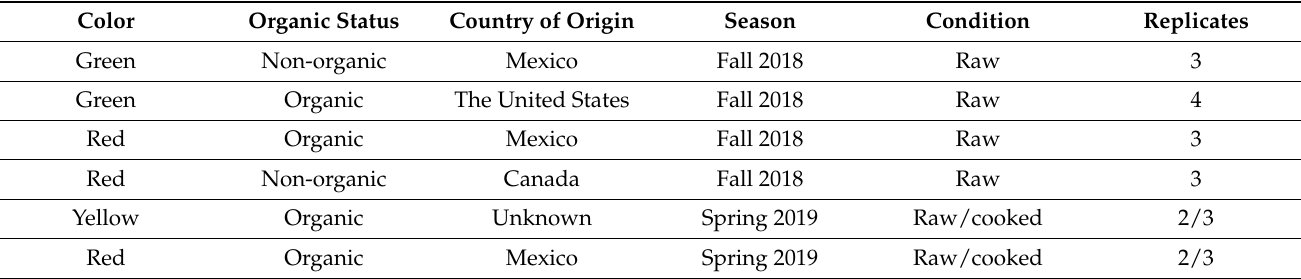
Table 2. Qualities of the bell peppers purchased in Denver,